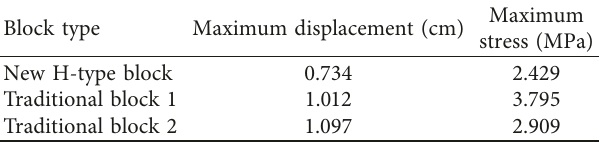
Table 6: Numerical simulation